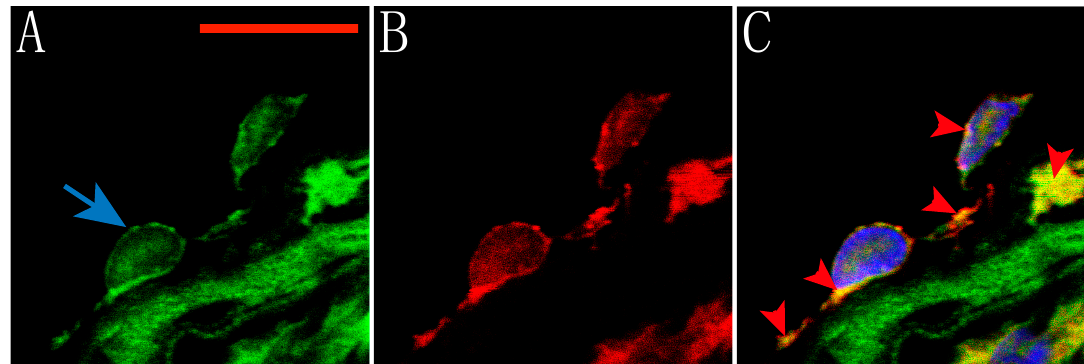
Figure 2. Expression of TRPV1 receptors in rat aorta endothelium. ( A ) TRPV1 was detected by a specific antibody and a FITC-conjugated secondary antibody (Green). The scale bar corresponds to 5 μ m. ( B ). The tissue was co-labeled with an endothelium-specific antibody and a secondary antibody conjugated with Alexa Fluor 568; the cells are located along the inner layer, indicated by a blue arrow. ( C ) The superimposition of the images highlights the co-localization of the receptor in the endothelial cells (Arrowheads). Nuclei were stained using Prolong Gold antifade with DAPI.